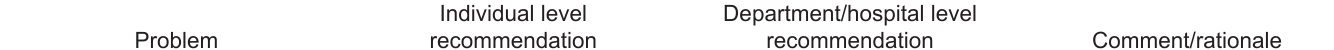
Table 4. Problems and recommendations at individual and department/hospital level for reducing emergency/internal medicine physician conflict and enhancing collaboration.